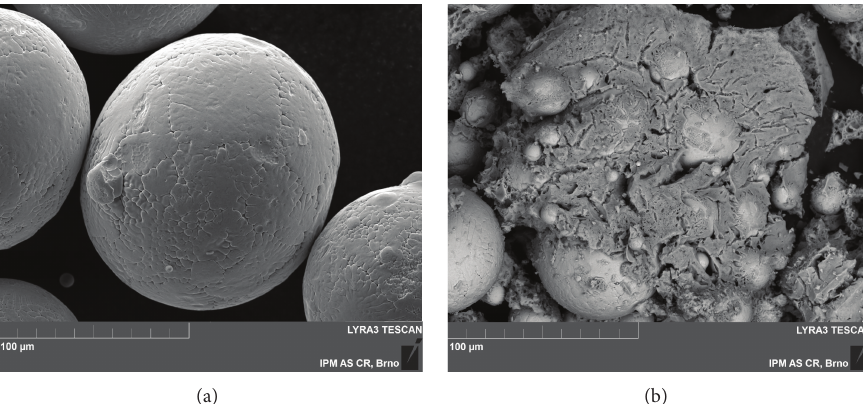
Figure 6: SEM images from (a) the original FeSi spherical powder (97% Fe and 3% Si); (b) the agglomerate of FeSi particles embedded in Mn 0.8 Zn 0.2 Fe 2 O 4